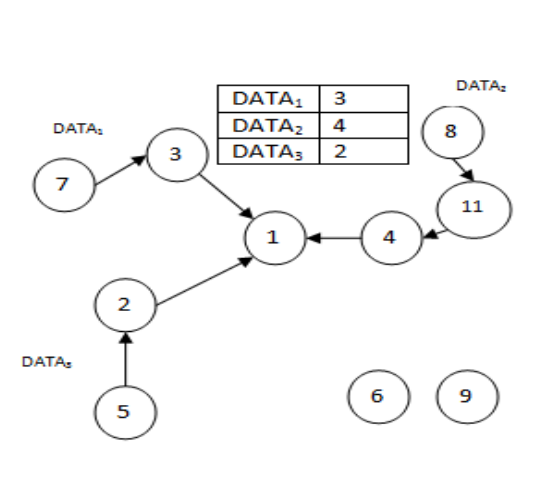
Figure. 5 Routing path selection